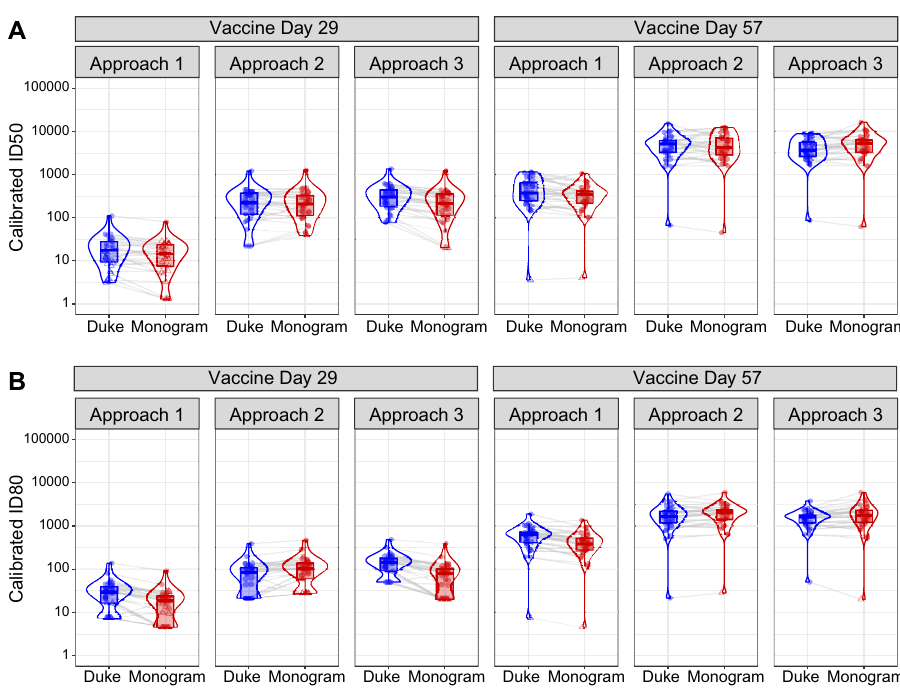
Figure 2. Distributions of calibrated ID50 (Panel A ) and ID80 (Panel B ) titers of vaccine recipient samples collected at Day 29 and Day 57, estimated by the three calibration approaches. In Approach 1, titers from each lab are calibrated to the WHO International Standard using the arithmetic mean-based calibration factor, expressed in International Units (IU50/ml for ID50; IU80/ml for ID80); in Approach 2, titers from each lab are calibrated to a common scale using an independent pool of clinical samples, assuming a bivariate normal distribution for the readouts from the two labs; in Approach 3, titers from the non-reference lab (Duke) calibrated to the reference lab (Monogram) using an independent pool of clinical samples, based on regressing titers from the reference lab on the non-reference lab. Circle-shape points indicate pre-calibration titers > LLoD; triangle-shape points indicate pre-calibration titers ≤